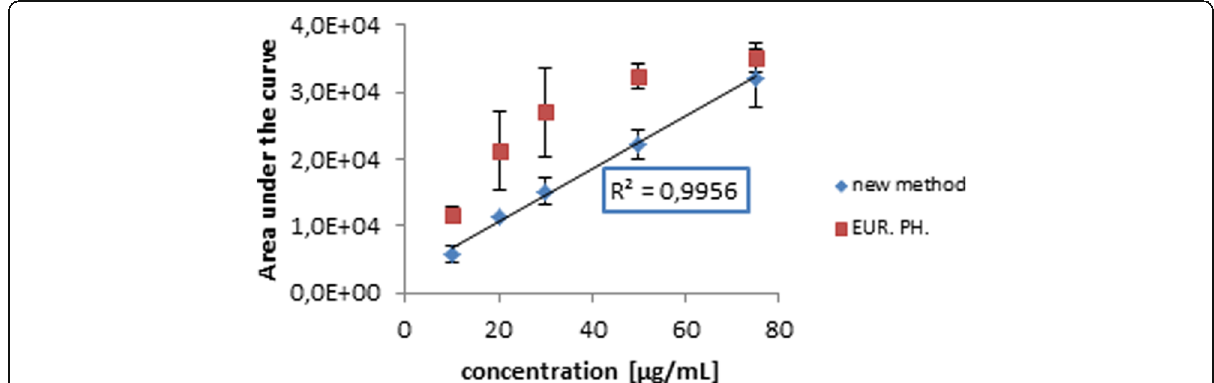
Fig. 8 Calibration curves of HEPES concentration obtained from a pixel-based analysis method by means of ImageJ applied to the Ph. Eur. and the improved